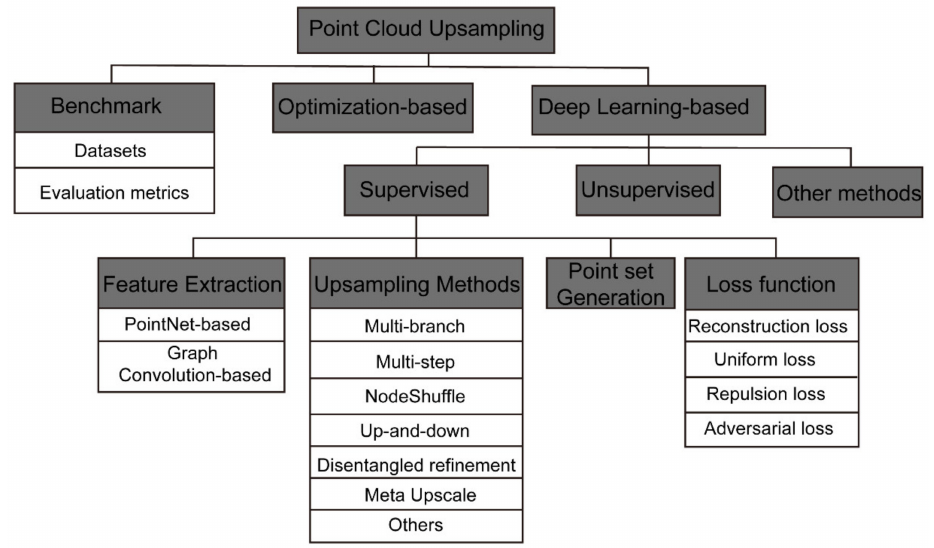
Figure 1. Hierarchically structured taxonomy of this